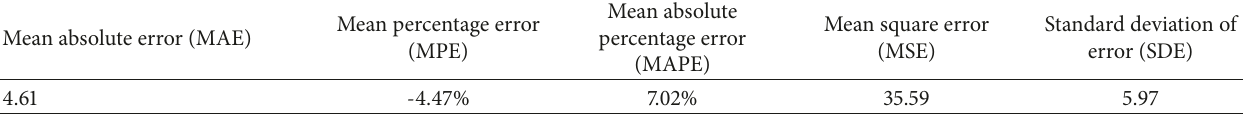
Table 3: Statistical results of prediction error for ecoscore.